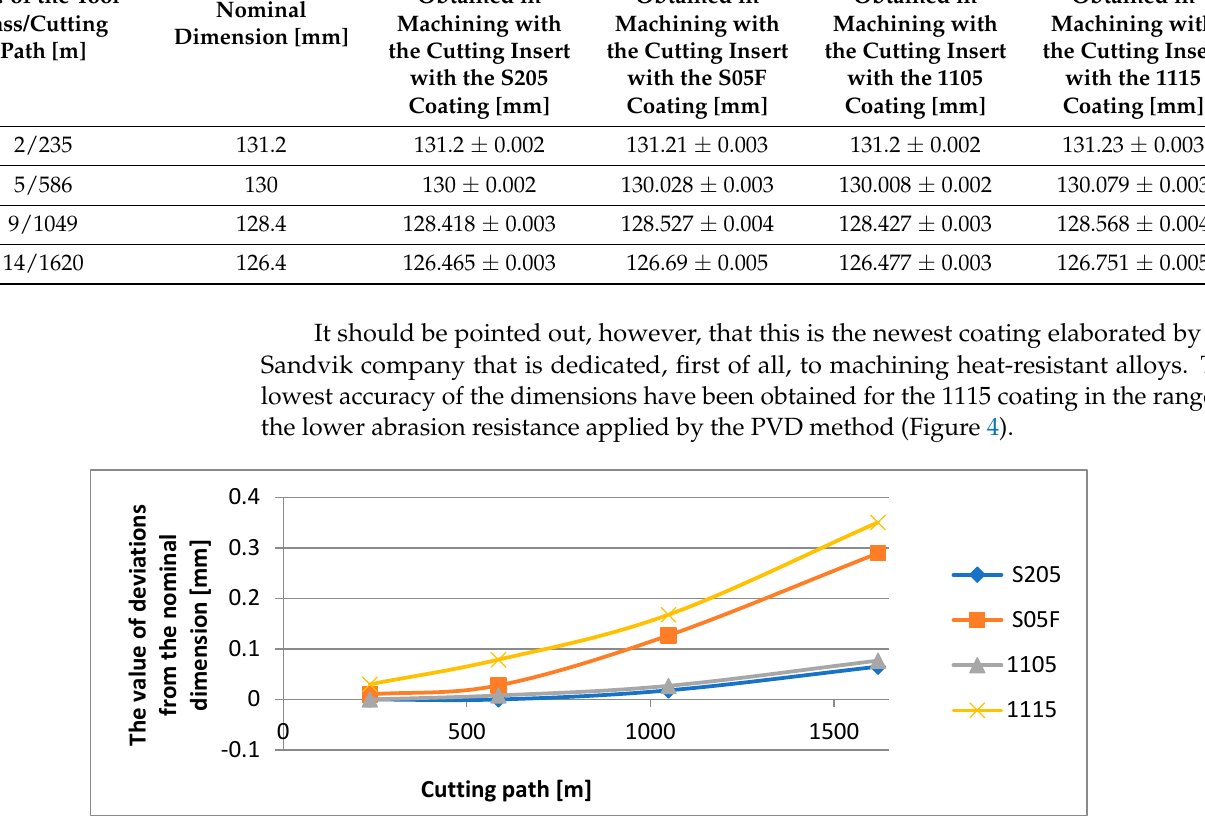
Figure 4. The value of deviations from the nominal dimension depending on the cutting path.